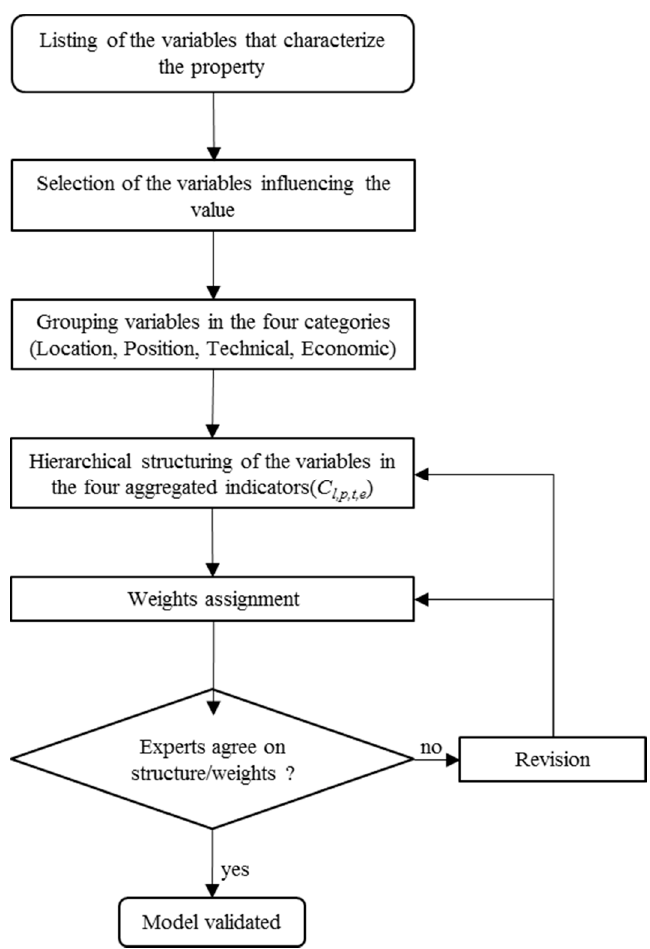
Figure 2. The procedure eliciting the structure of the aggregate indicators.